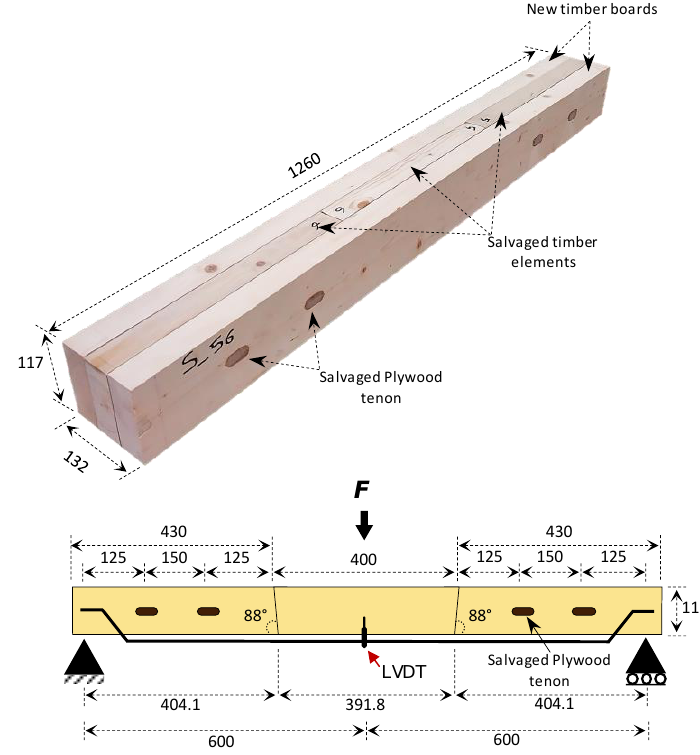
Figure 1. The dimensions of the salvaged timber elements in the small-scale DLT panels and the three-point bending test set-up. Dimensions in mm.